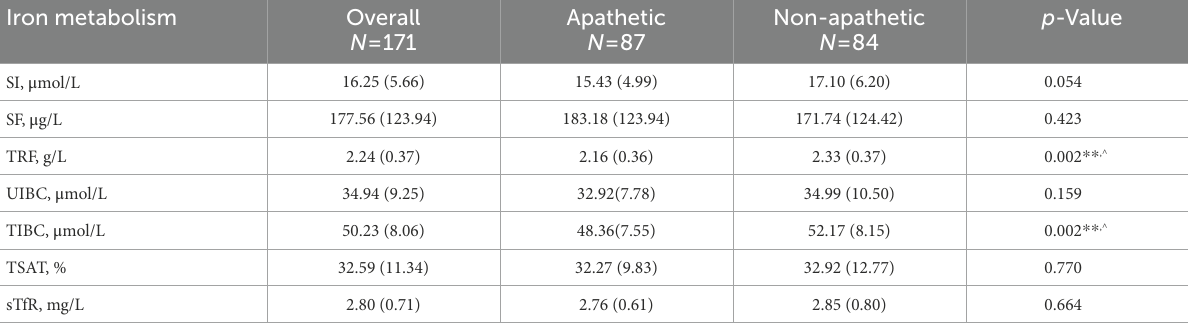
TABLE 2 The levels of iron metabolism in serum between apathetic and non-apathetic groups. Iron metabolism